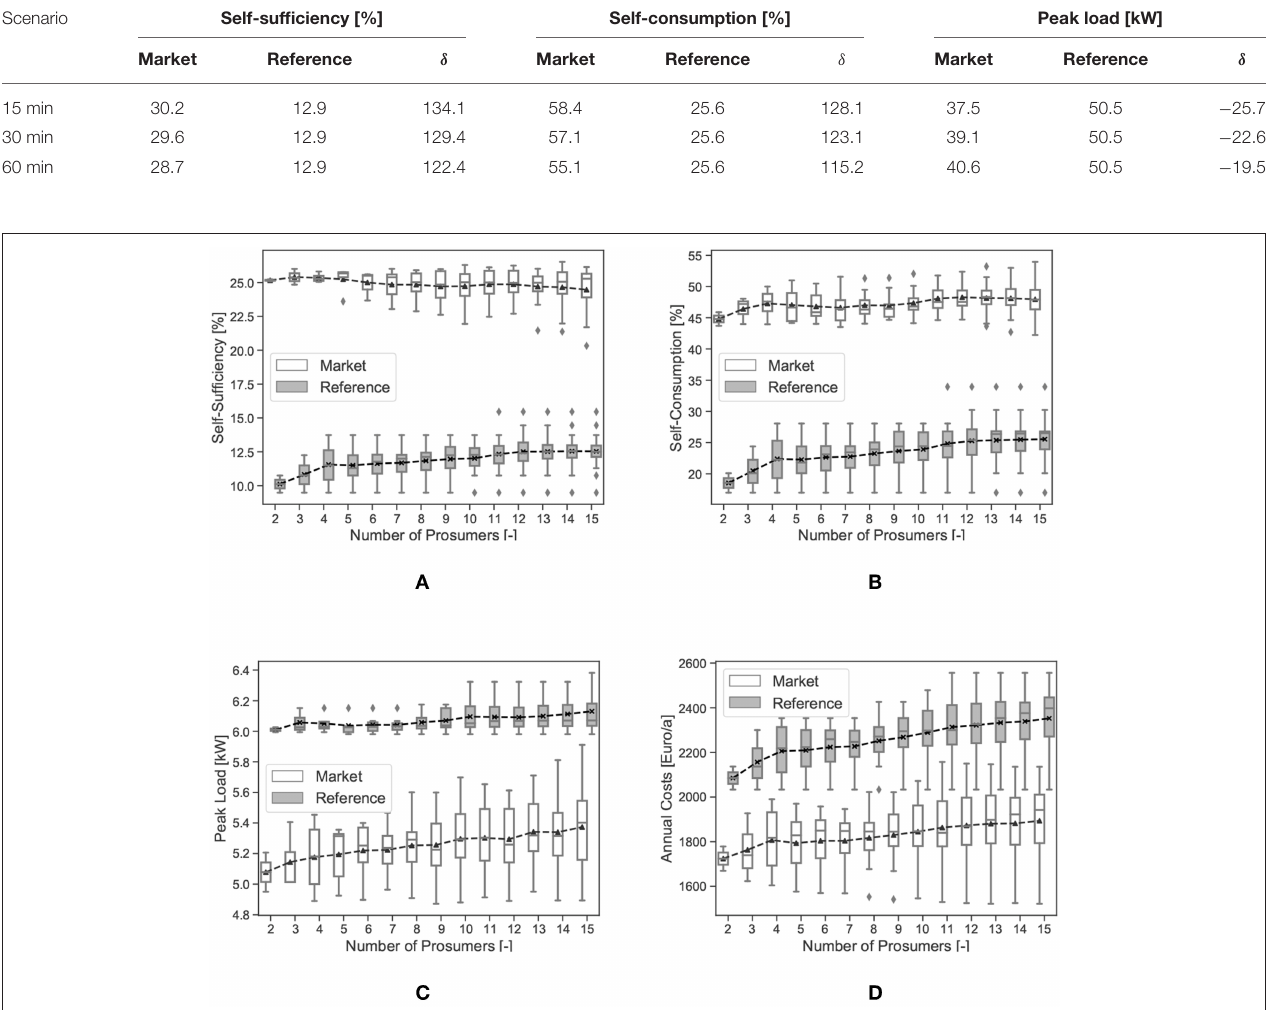
FIGURE 6 | Metrics of scenario subgroup B1 at the prosumer level, (A) self-sufficiency, (B) self-consumption, (C) peak load, (D) annual costs.